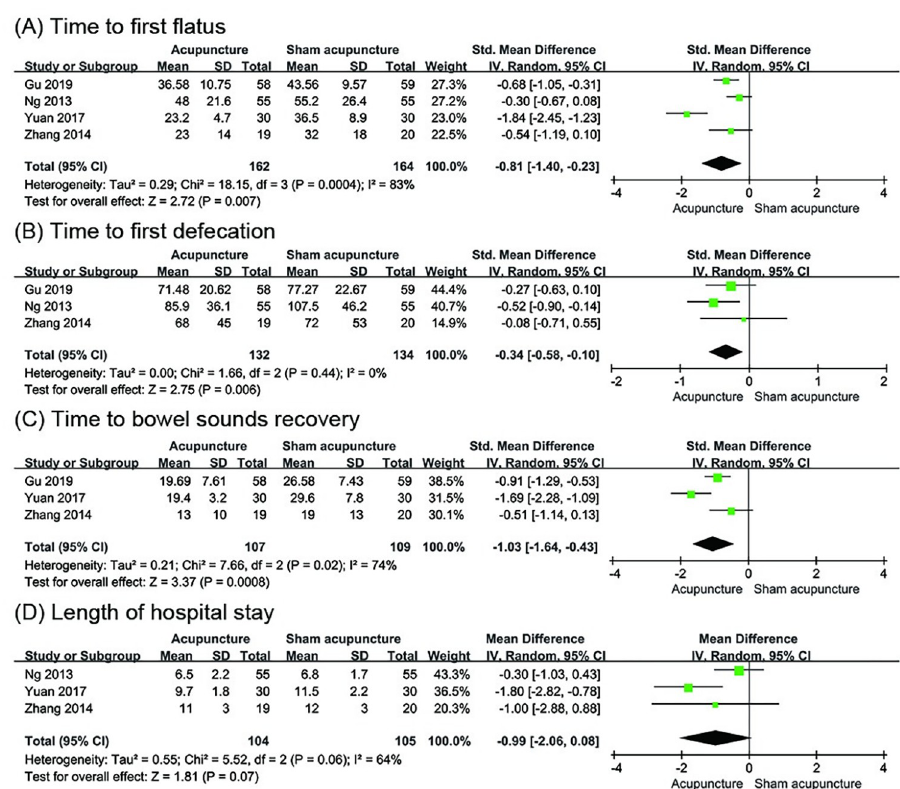
Fig 4. Meta-analysis of acupuncture versus sham acupuncture for (A) Time to first flatus, (B) Time to first defecation, (C) Time to bowel sounds recovery and (D) Length of hospital stay.